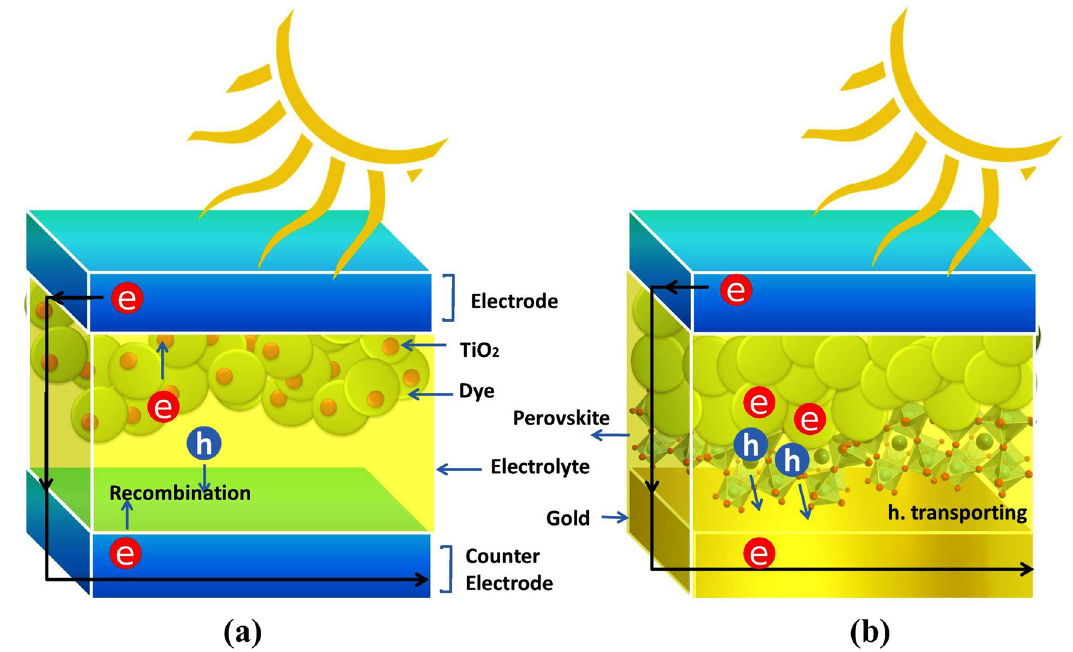
Figure 8: The di ff erence between ( a ) the dye - sensitized solar cell ( DSSC ) and ( b ) the